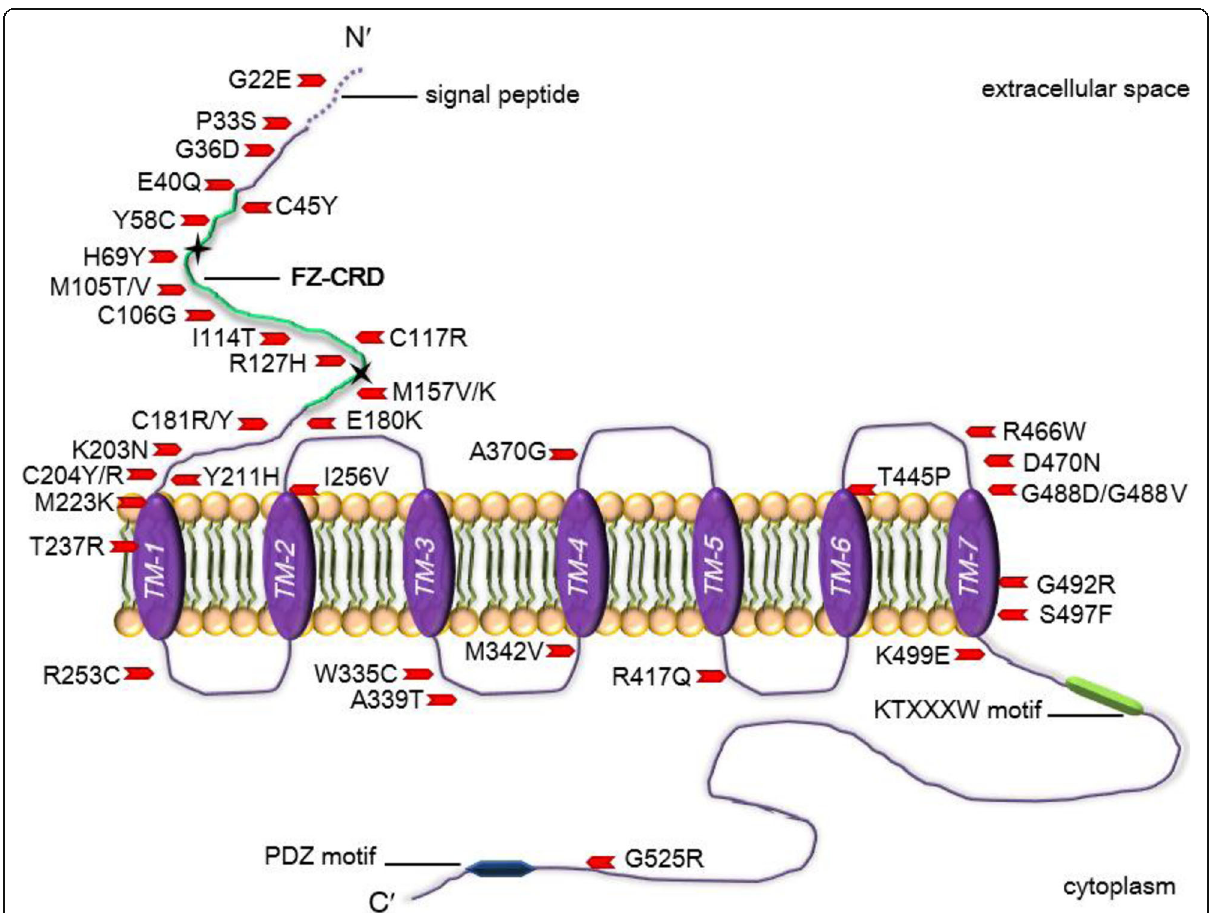
Fig. 4 Schematic representation showing 40 reported FZD4 missense mutations dispersed across the protein and are associated with pathogenic FEVR. FZD4 contains a signal sequence at the amino (N ′ ) terminus from amino acids 1 and 36/37; a conserved FZ-CRD region highlighted in green of approximately 122 amino acids in the extracellular domain containing a motif of 10 spaced cysteines between amino acid positions 40 through 161; a seven-pass TMD region labelled TM1 – 7 within amino acid positions 210 through 514; and a cytoplasmic domain with a KTXXXW motif found at amino acid positions 499 through 504, and a PDZ motif located close to the C ′ terminal at amino acid positions 535 through 537. The two potential N-glycosylation sites are indicated by black stars at amino acid positions 59 and 144. Smallwood et al. have shown that the binding of Norrin to the CRD domain of FZD4 extends to include residue C204 (Smallwood et al. 2007). Amino acid positions and domains can be accessed from